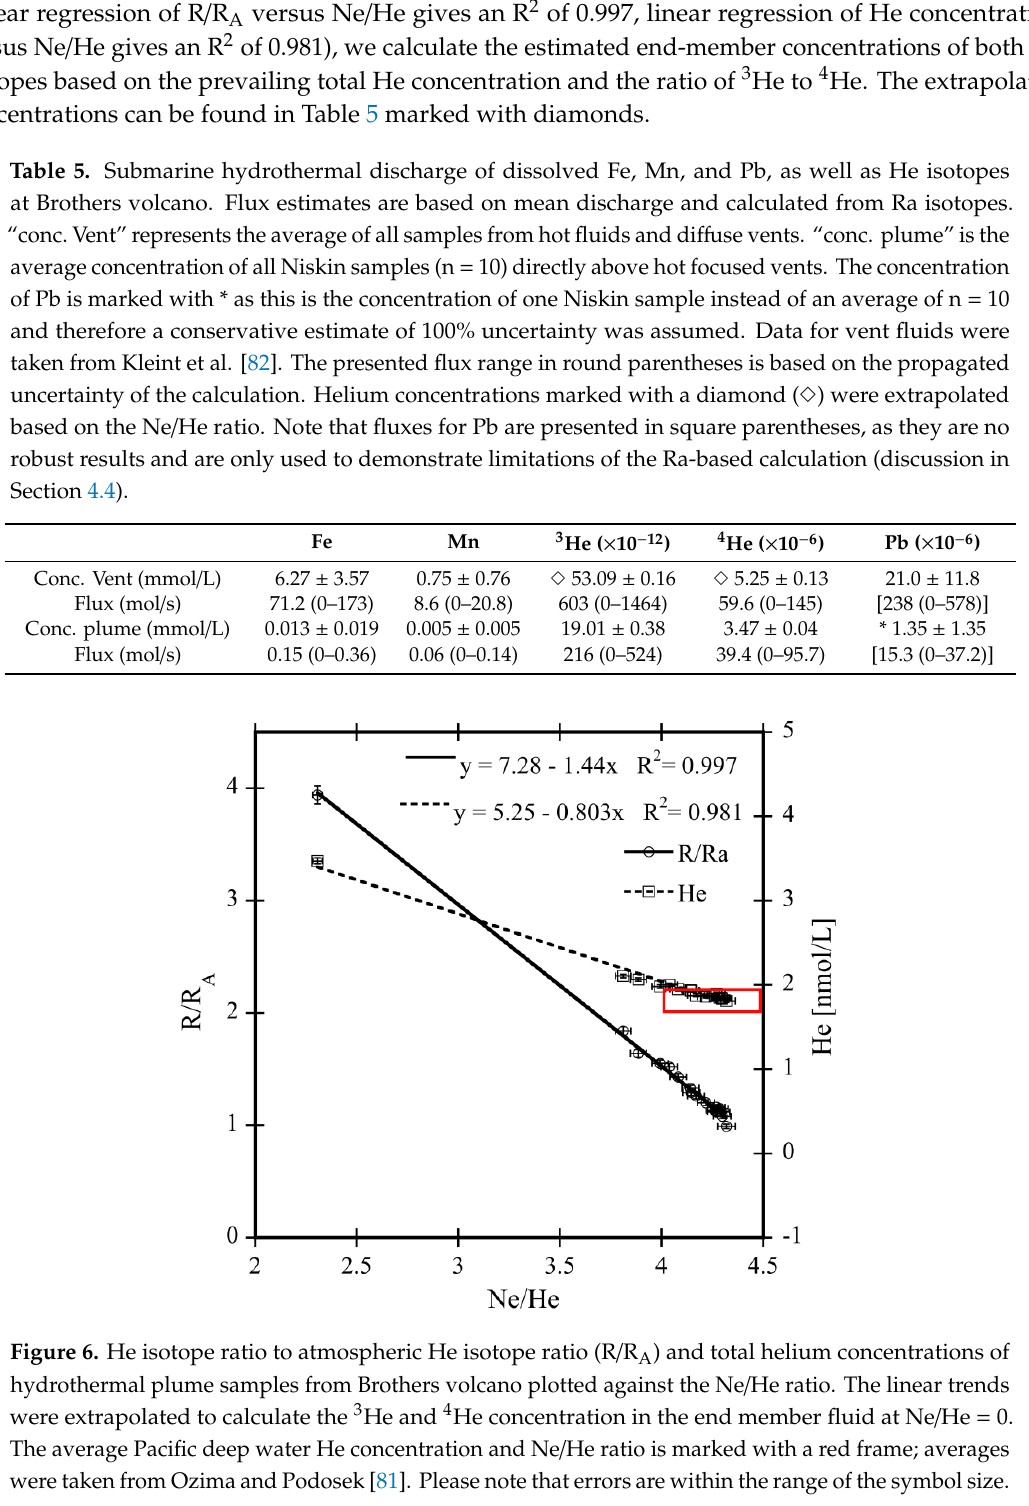
Table 5. Submarine hydrothermal discharge of dissolved Fe, Mn, and Pb, as well as He isotopes at Brothers volcano. Flux estimates are based on mean discharge and calculated from Ra isotopes. “conc. Vent” represents the average of all samples from hot fluids and di ff use vents. “conc. plume” is the